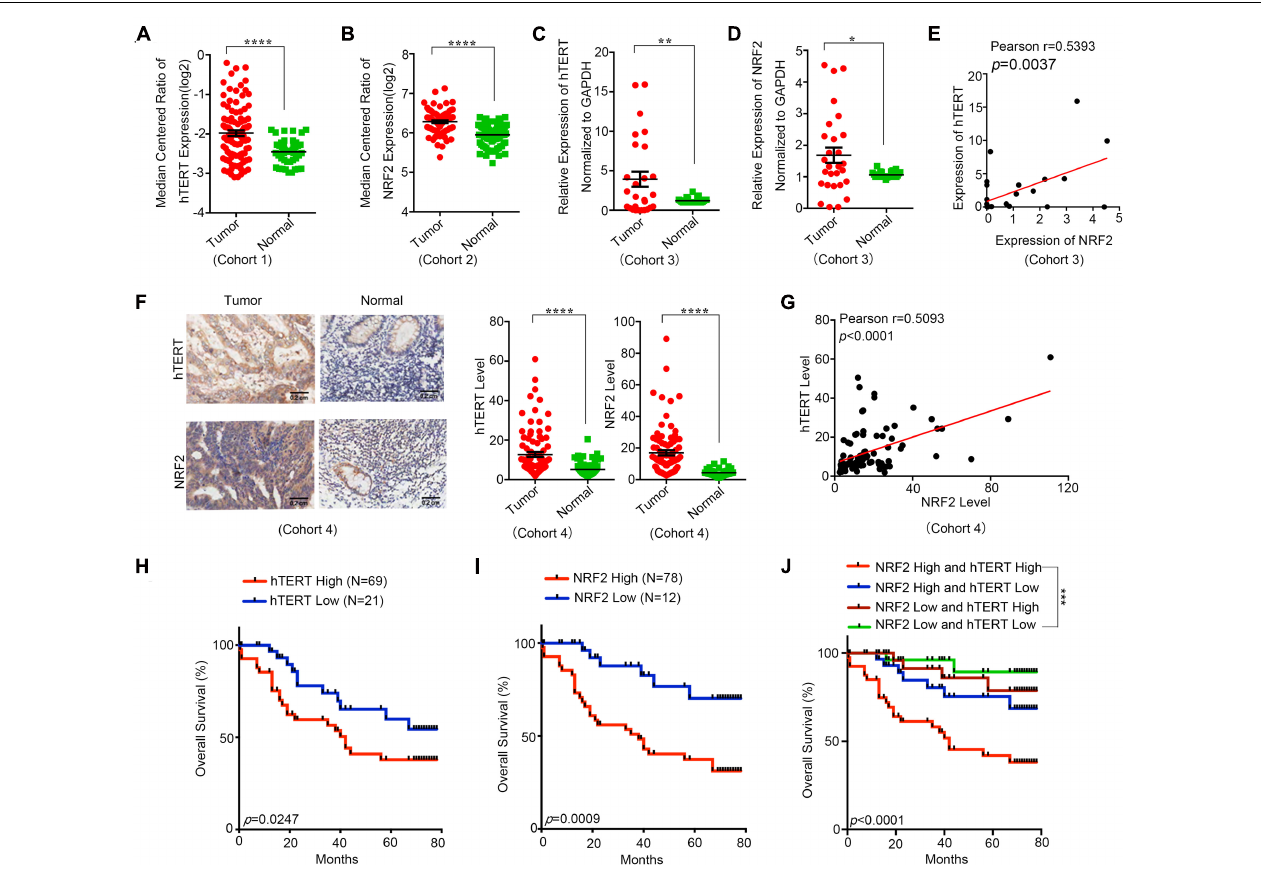
FIGURE 1 | Human telomerase reverse transcriptase (hTERT) and NRF2 are highly expressed in CRC tissues and associated with poor diagnosis. (A) hTERT expression in CRC tissues and adjacent normal tissues was investigated in Oncomine database (Cohort1). (B) NRF2 expression in CRC tissues and adjacent normal tissues was investigated in Oncomine database (Cohort2). (C) hTERT mRNA expression in CRC tissues and paired adjacent normal tissues was identified by qRT-PCR (Cohort3). (D) NRF2 mRNA expression in CRC tissues and paired adjacent normal tissues was identified by qRT-PCR (Cohort3). (E) Regulation analysis of the correlation between hTERT and NRF2 (Cohort3). Each point represents one cancer sample. (F) Representative immunohistochemical staining and expression level statistics of hTERT and NRF2 in CRC tissues and paired adjacent normal tissues (Cohort4). (G) Regulation analysis of the correlation between hTERT and NRF2 (Cohort4). Each point represents one cancer sample. (H) Kaplan–Meier analysis of the overall survival of CRC patients with different hTERT expression levels ( p < 0.05, log-rank test). (I) Kaplan–Meier analysis of the overall survival of CRC patients with different NRF2 expression levels ( p < 0.05, log-rank test). (J) Kaplan–Meier analysis of the overall survival of CRC patients with different hTERT and NRF2 expression levels ( p < 0.05, log-rank test). * p < 0.05; ** p < 0.01; *** p < 0.001; **** p < 0.0001; ns, no significance.